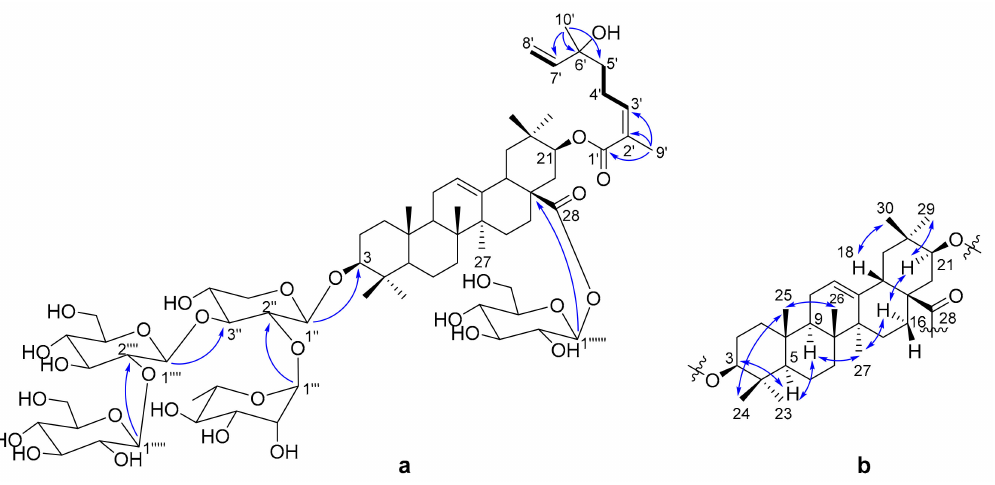
Figure 2. ( a ) Key 1 H- 1 H COSY ( − ) and selected HMBC correlations (H → C) of 1 ; ( b ) Key NOESY ( ↔ ) correlations of 1